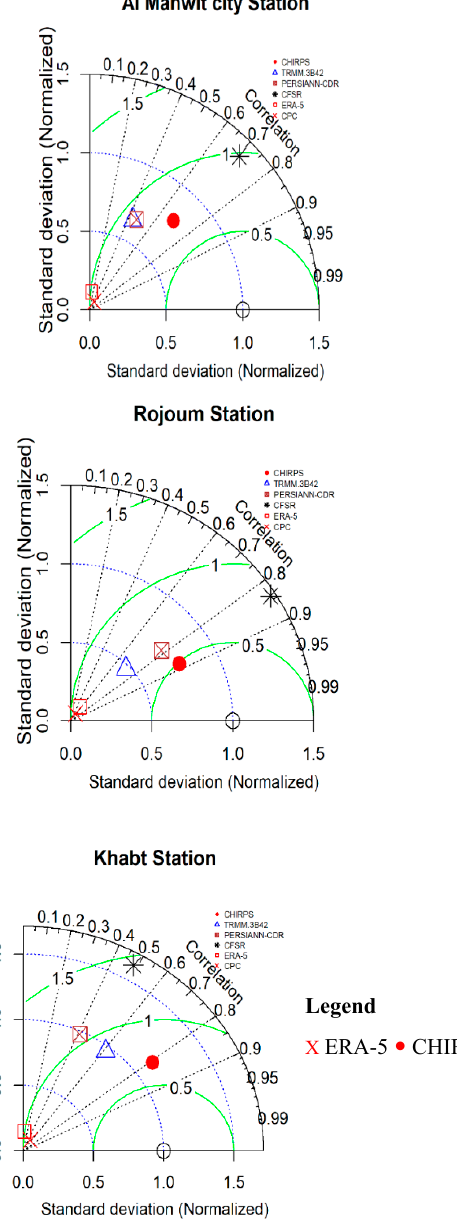
Figure 4. Taylor diagram showing the agreement between ground monthly observations and precipitation products over the five stations covering the period of 1998–2007.